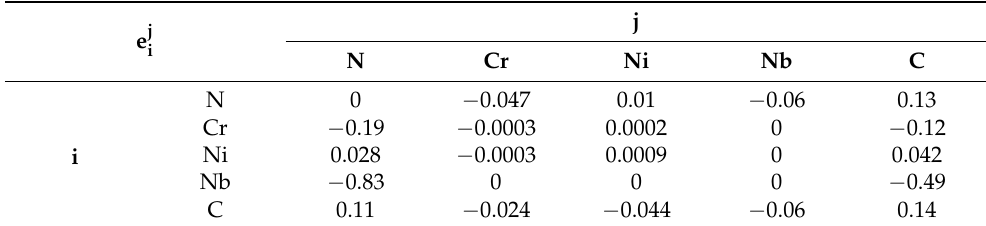
Table 2. First-order interaction parameter e j from [13].